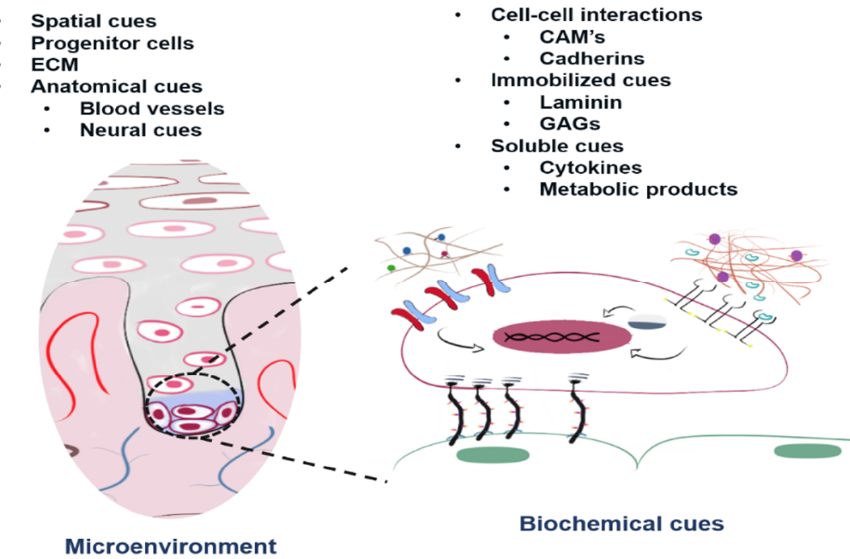
Figure 1. Biochemical and microenvironmental cues of a prototypical stem cell niche. Adapted with permission from ref. [9]. Copyright Lutolf & Blau’s Name.